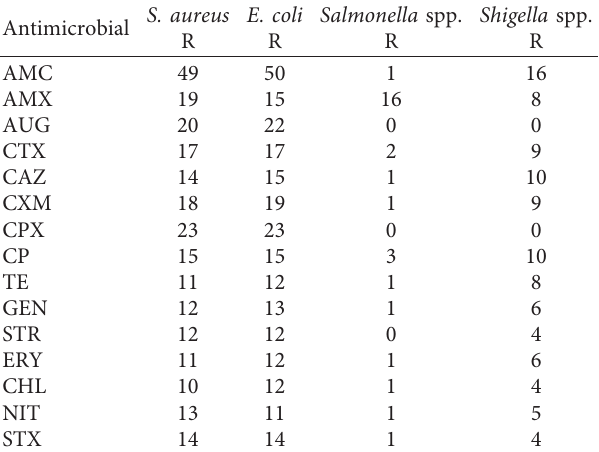
Table 6: Bacterial organisms isolates with different mean and standard